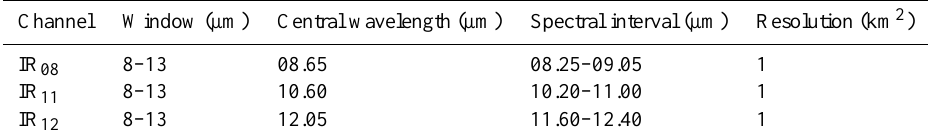
Table 1. Window channels characterizations of Infrared Imaging Radiometer